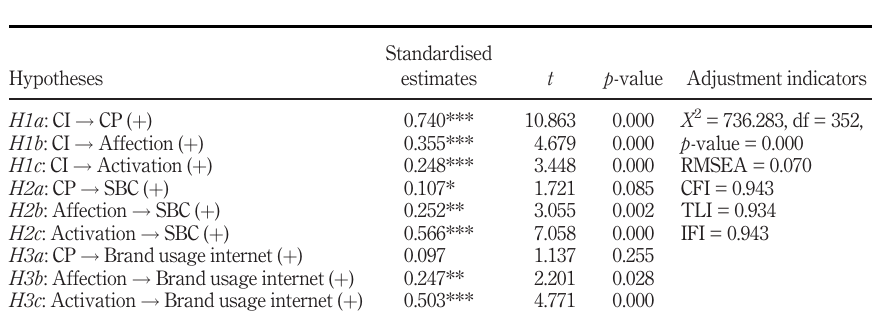
Table II. Results of SEM